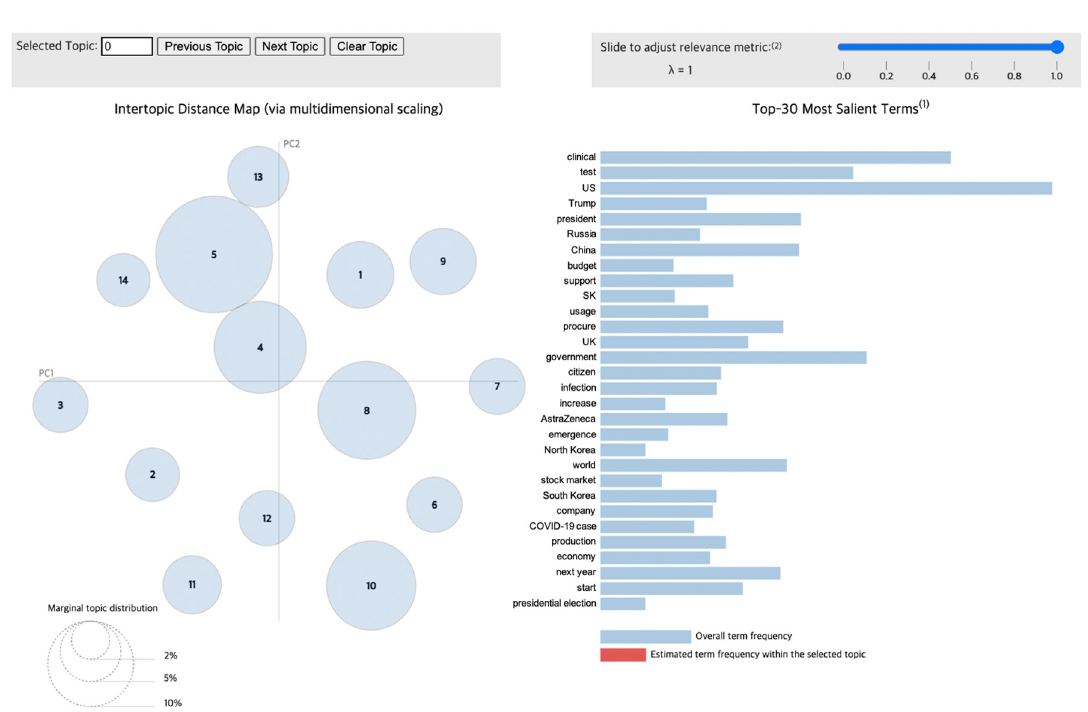
Figure 5. Topic visualization of Phase 1.